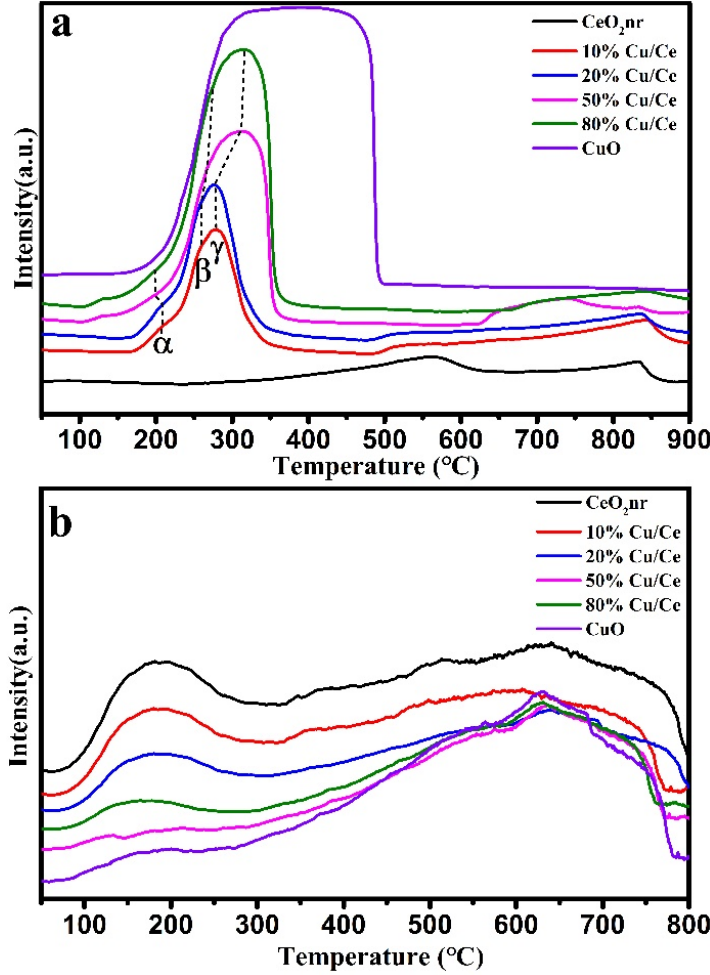
Figure 6. ( a ) H 2 -TPR and ( b ) O 2 -TPD profiles of the CuO/CeO 2 catalysts. Table 2. H 2 consumption amounts of as-prepared catalyst calculated by H 2 -TPR. O 2 − TPD tests were performed on the CuO/CeO 2 catalysts, CeO 2 , and CuO to investi ‐ Catalyst